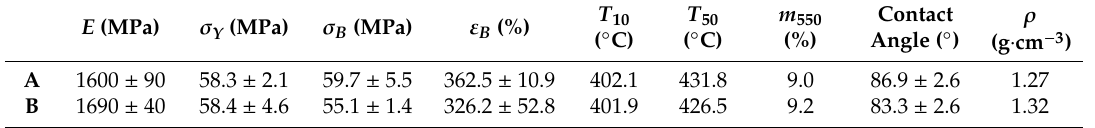
Table 3. Experimental properties of virgin PETG (sample A) and recycled PETG (sample